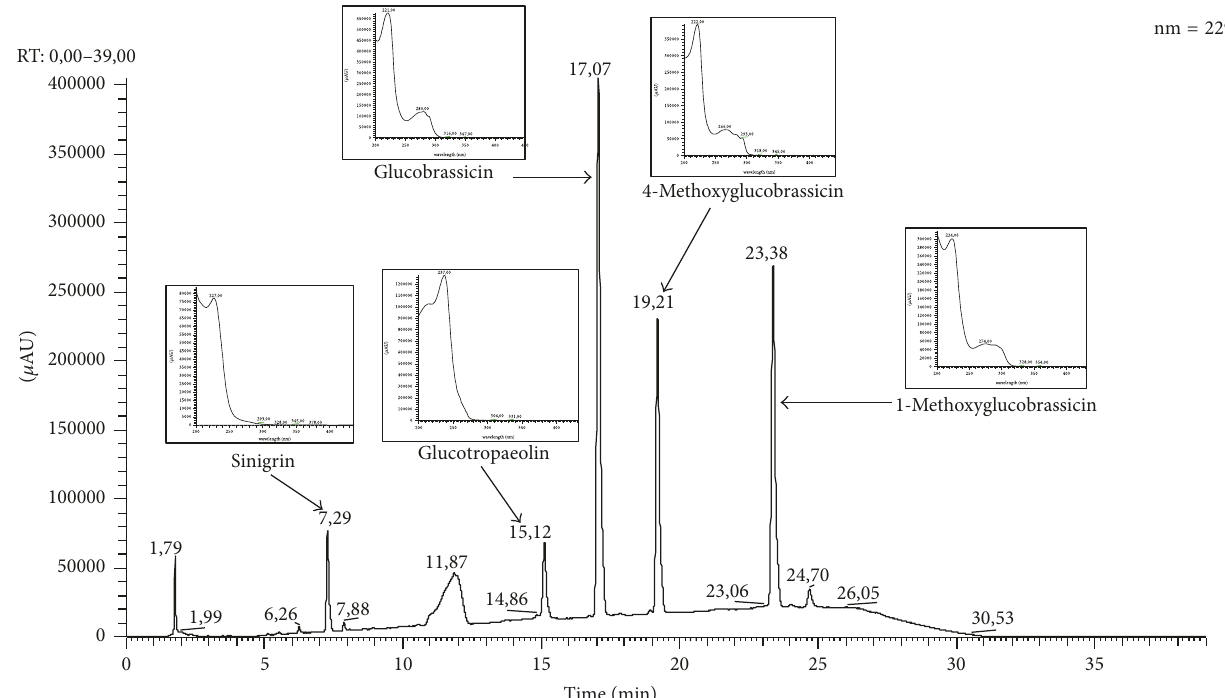
Figure 2: Typical chromatogram of GLS identified in Chinese cabbage hairy roots and respective UV